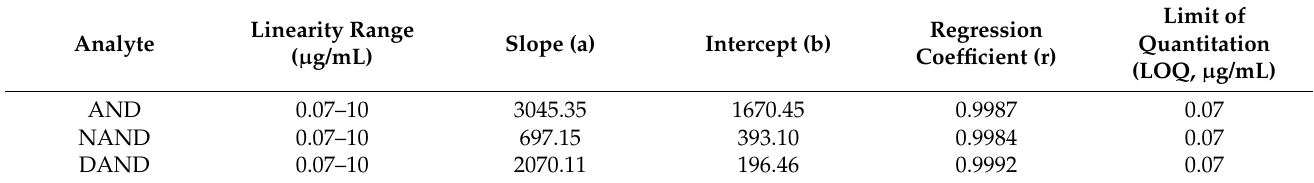
Table 6. Method calibration data for MS detection of